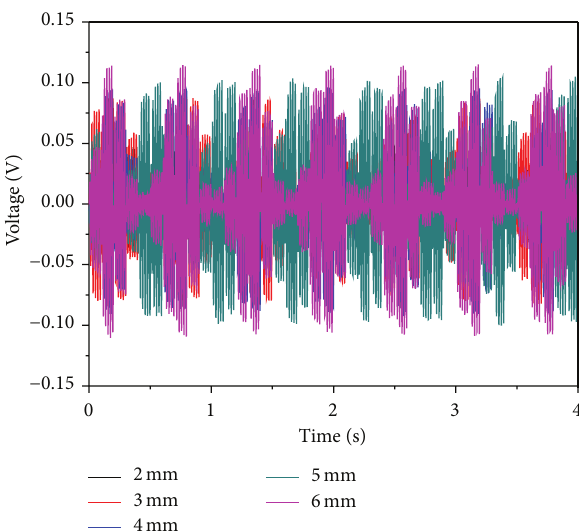
Figure 14: Self-induced voltage under different damper displace- ment input as the DC input was set as 0.5 A.